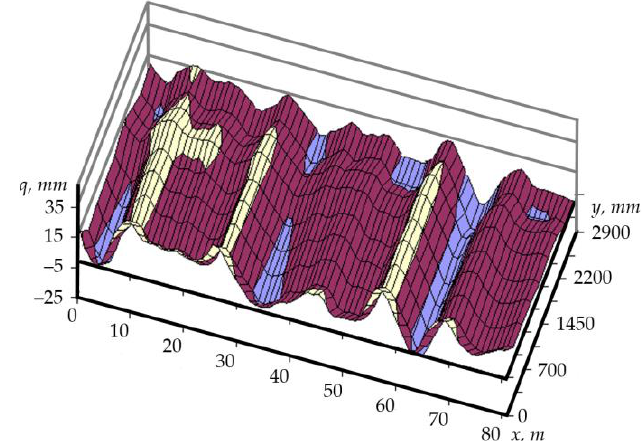
Figure 5. Spatial fragment of a road surface microprofile span.